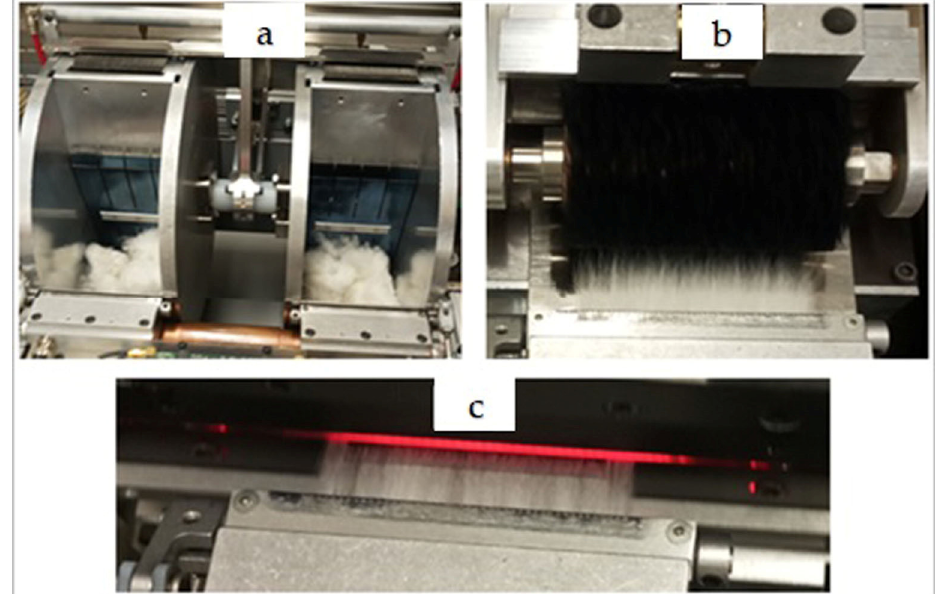
Figure 1. An illustration of the operation of the HVI length measurement: ( a ) fibrosampler with a raw cotton sample used to prepare a cotton beard; ( b ) brush used to remove loose fibers and extraneous materials; and ( c ) a beam of light used to scan the fiber beard.